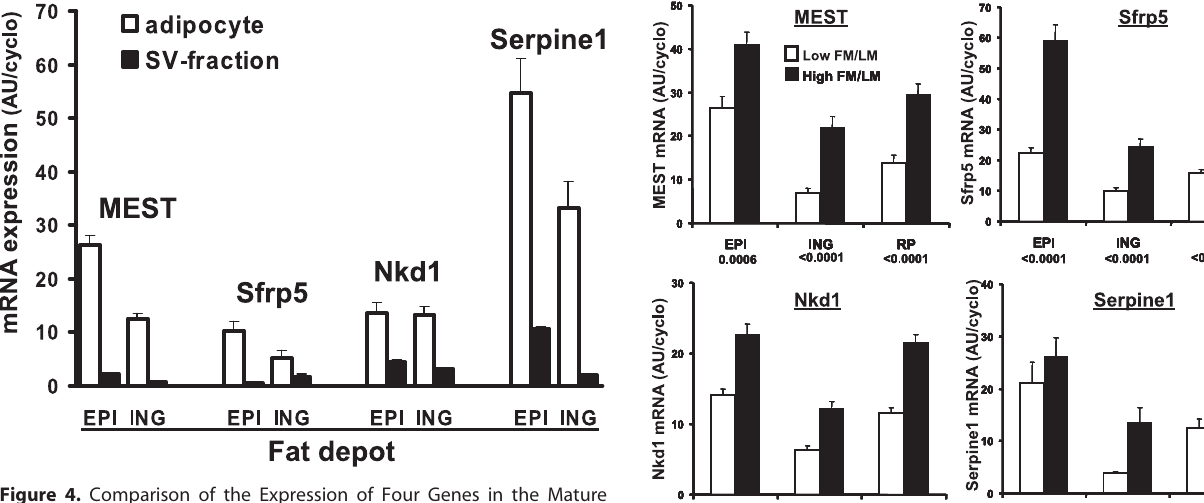
Figure 4. Comparison of the Expression of Four Genes in the Mature Adipocyte and Stromal Vascular Fraction of the Epididymal and Inguinal Fat Pads Isolated from Four Pools of RNA Derived from Tissue Isolated from Eight Mice Each pool consisted of equal amounts of RNA from two mice. All comparisons between adipocyte and stromal vascular fractions were significant ( p , 0.01) except for ING fat SFRP5 ( p ¼ 0.09). EPI ¼ epididymal; ING ¼ Inguinal